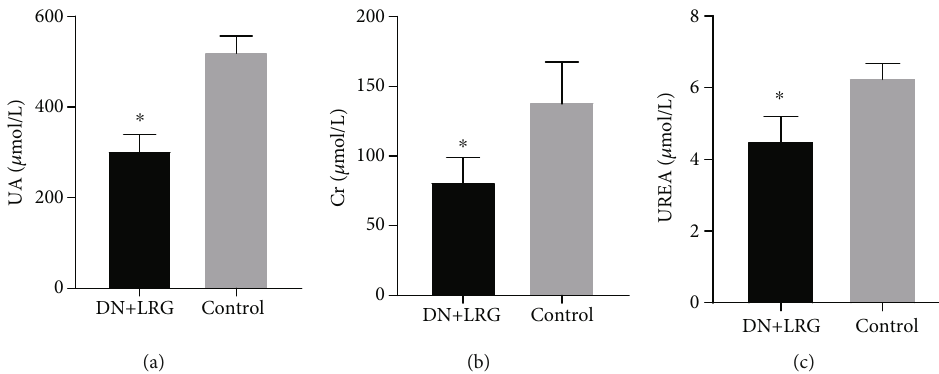
Figure 3: UA, Cr, and UREA levels. Control: diabetic nephropathy group; DN+LRG: diabetic nephropathy+liraglutide group; Cr: creatinine; UA: uric acid. ∗ P < 0 : 05 vs. the control.